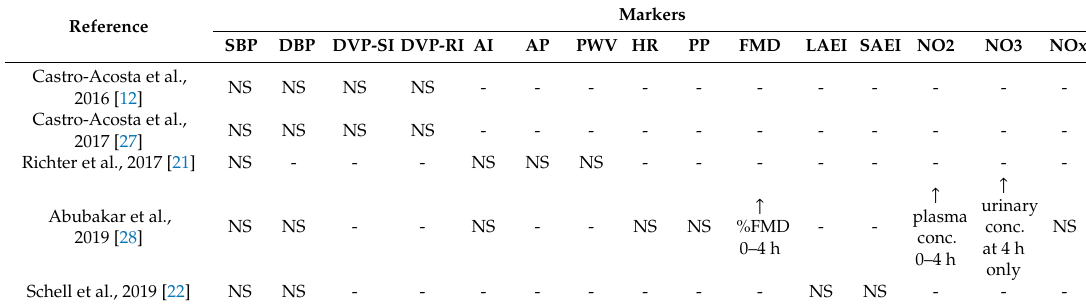
Table 4. E ff ects of anthocyanin intake in composite meals on markers for vascular functions.